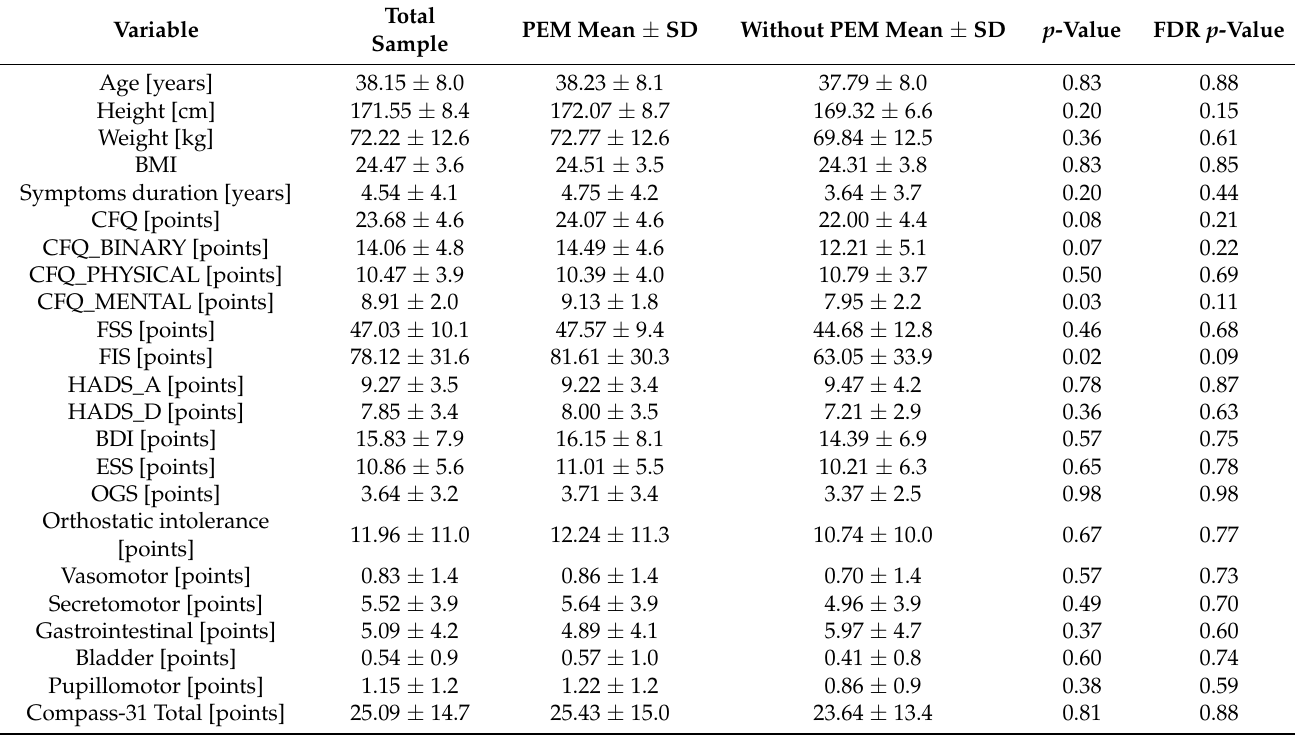
Table 1. Demographic data of total examined sample ( n = 101) and comparison of demographic data and questionnaires results of patients with PEM and without PEM, respectively.